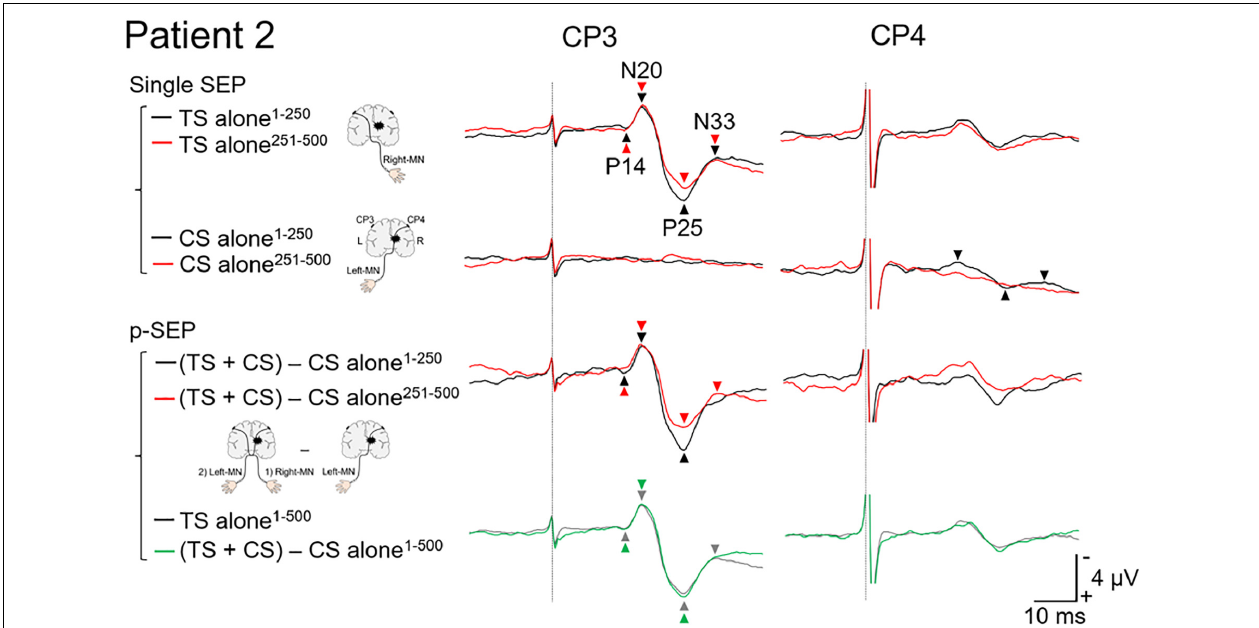
FIGURE 3 | Paired median nerve somatosensory evoked potential in patient 2. Left panels : to investigate the effect of conditioning stimulus (CS) on the SEP induced by the test stimulus (TS), the single median nerve SEPs (single SEP) (left-MN: CS alone), and the paired median nerve SEPs (p-SEP) were recorded at the CP3 and CP4 electrodes (Ragert et al., 2011). In the p-SEP recording, the left-MN stimulus (CS) was performed 1 ms after the right-MN stimulus (TS). Right panels : all SEP waveforms at CP3 and CP4 from patient 2. We compared the SEP averaged over the first 250 epochs with the SEP averaged over the second 250 epochs (total number of epochs recorded: 500). Black line: the SEP averaged over the first 250 epochs. Red line: the SEP averaged over the second 250 epochs. Gray line: the SEP averaged over all epochs (500 epochs) (TS alone condition). Green line: the SEP averaged over all epochs (500 epochs) [(TS + CS) − CS alone condition]. Dotted line: the time duration of stimulation. MN, median